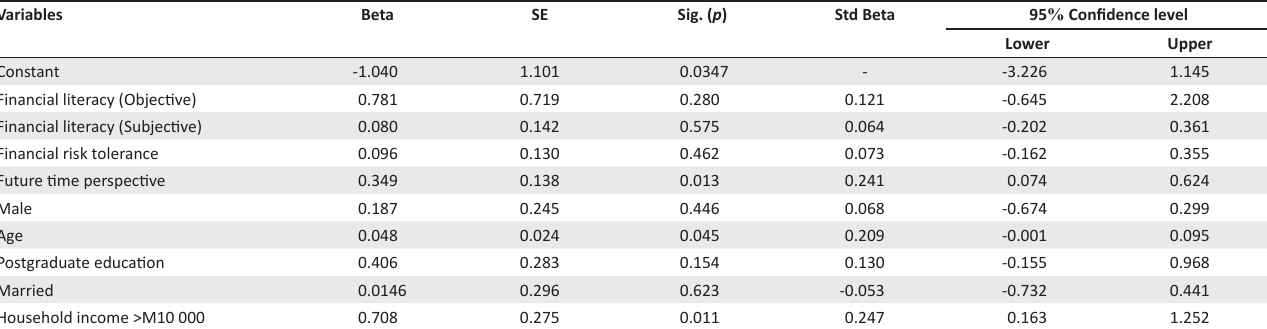
TABLE 4: Linear model of predictors for the subsample of banking